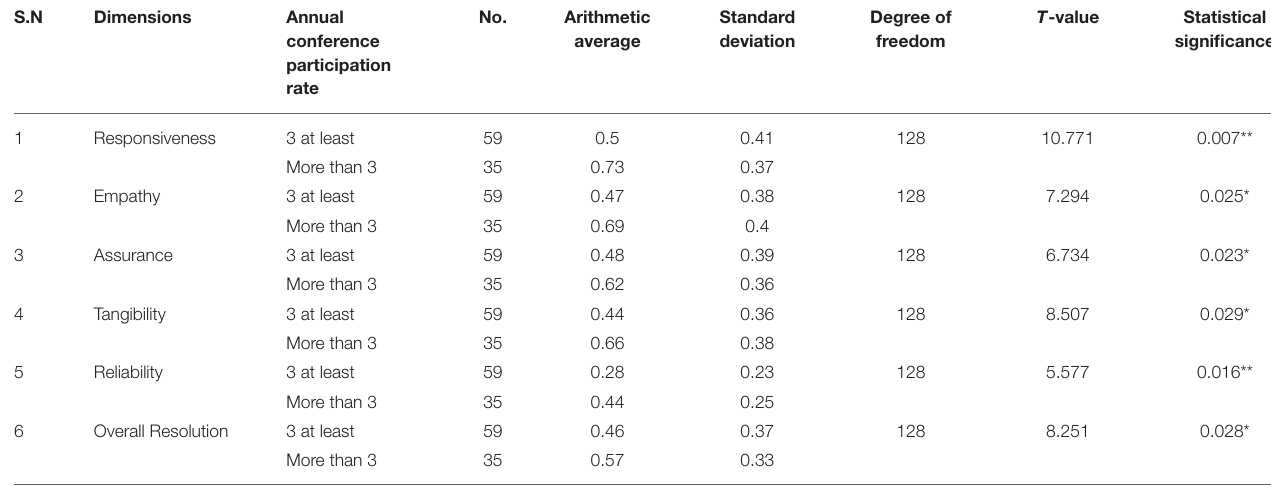
TABLE 7 | T -test shows differences in the sample individuals’ responses according to the annual conference participation rate variable by calculating the gap.